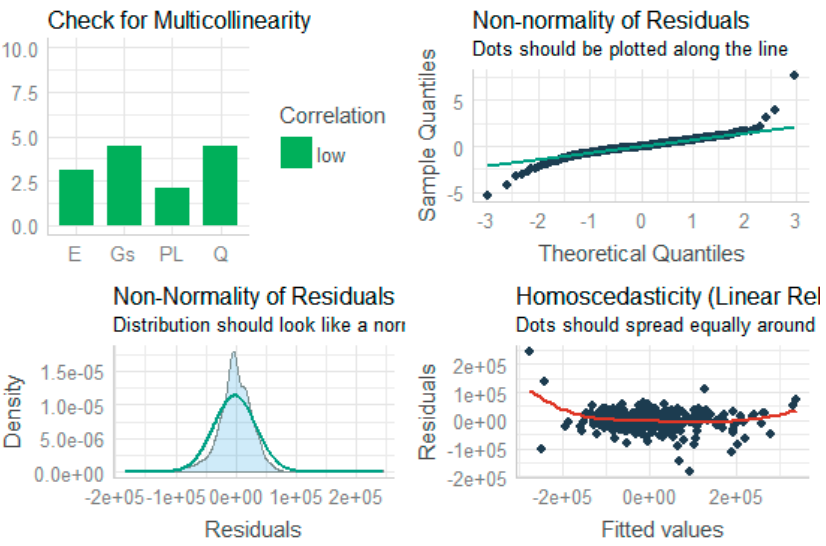
Figure 6. Verification of model assumptions (multicollinearity, non-normality of residuals, and homoscedasticity).